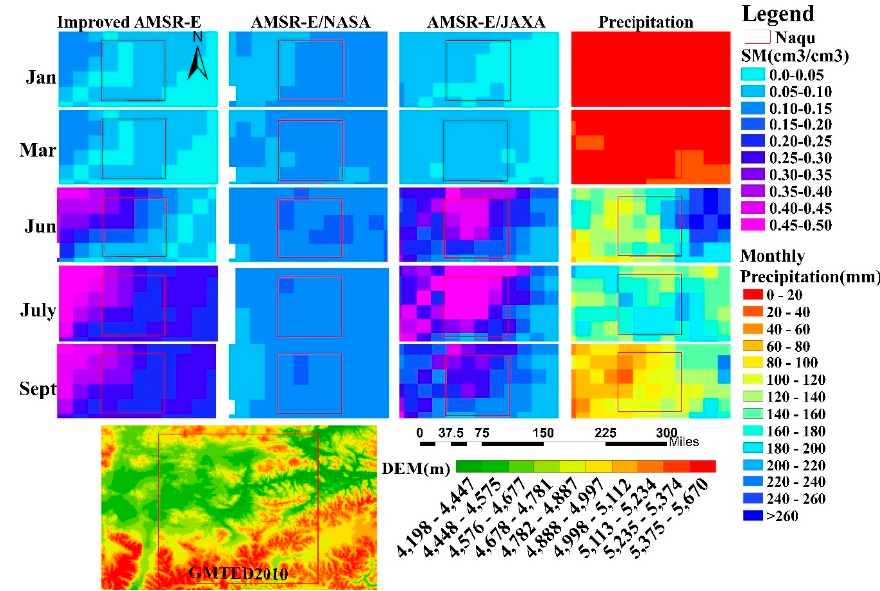
Figure 9. Spatial and temporal comparison of the monthly AMSR-E/NASA, AMSR-E/JAXA, I_AMSR-E SM and precipitation in January, March, June, July and September in 2011, the Naqu area (upper panel); Digital Elevation Model (DEM, lower panel).